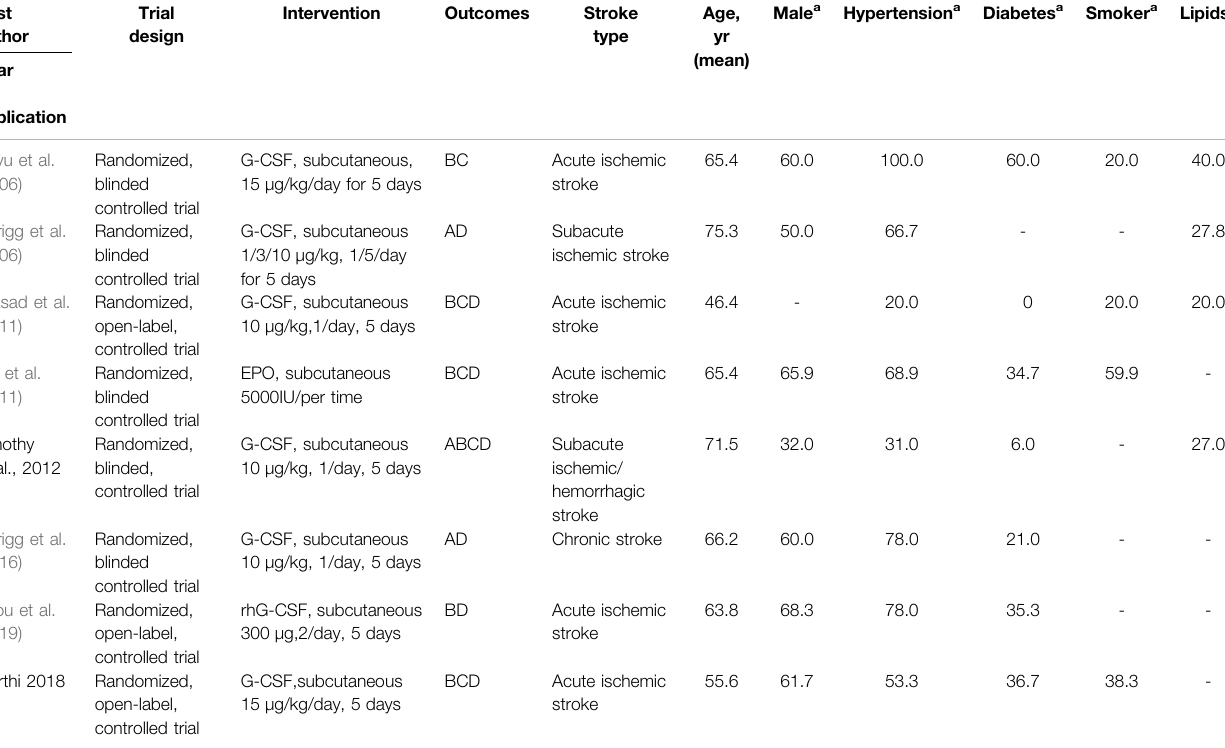
TABLE1 | Clinical studies of CSF in stroke.